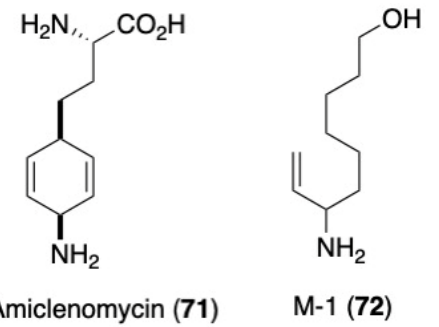
Figure 7. The structure of amiclenomycin and analogue M-1 [110] .